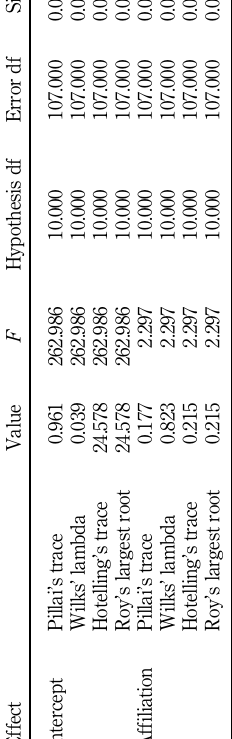
Table 3. Multivariate tests